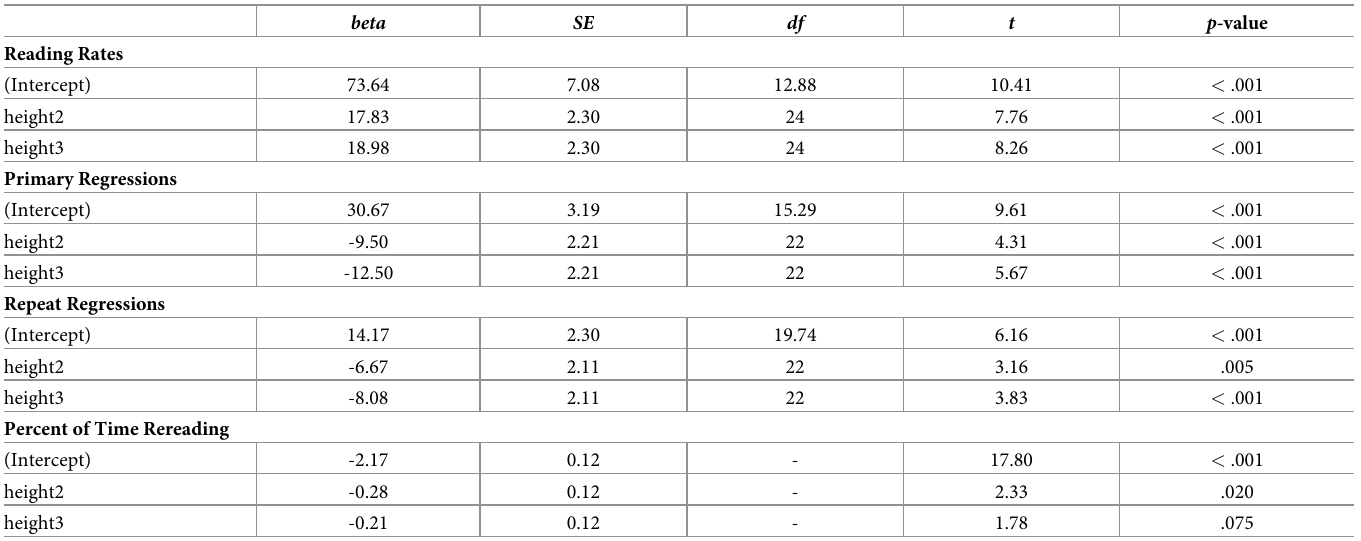
Table 1. Statistics table of the fixed effects for each model.